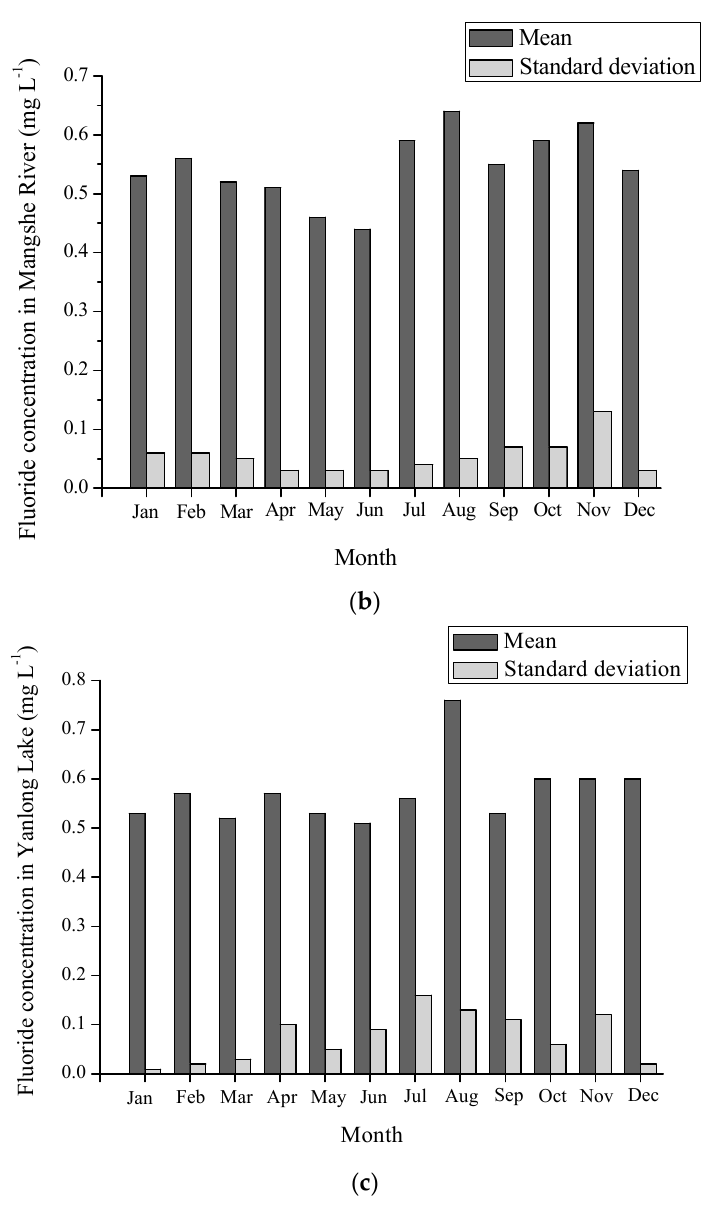
Figure 2. Temporal variations of fluoride concentrations in three drinking water sources (a) Monthly fluoride concentration in the Tongyu River. (b) Monthly fluoride concentration in the Mangshe River. (c) Monthly fluoride concentration in the Yanlong Lake.